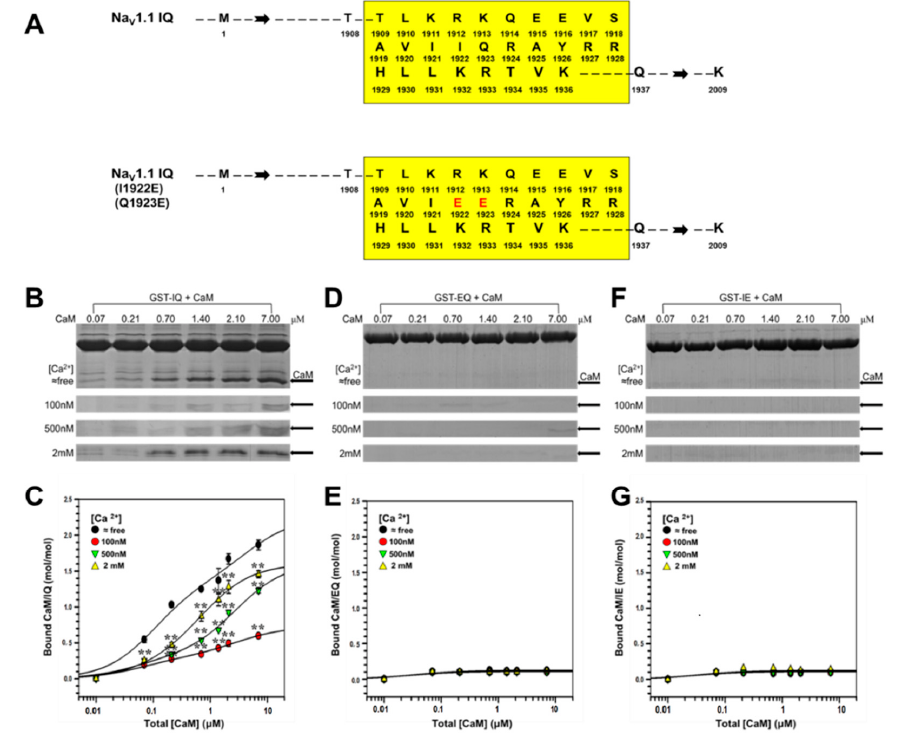
Figure 2. Interaction of the IQ of Na V 1.1 and its mutant with CaM by pull-down assay. ( A ) Schematic illustrations of Na V 1.1 IQ domain and its mutants EQ and IE. Amino acid sequences from human Na V 1.1 IQ are presented with black letter code. The mutated amino acid of Na V 1.1 EQ and IE is indicated with red letter. IQ, EQ and IE peptide contains amino acids from 1909 to 1936. ( B , D , F ) GST pull-down assay for the binding of CaM to IQ, EQ, or IE. ( B , D , F ) GST-fusion IQ, EQ, and IE was incubated with increasing concentrations of CaM (0.07 to 7 μ m) at fixed [Ca 2+ ] of ≈ free, 100 nM, 500 nM, and 2 mM. Protein bands are stained by Coomassie Brilliant Blue. CaM protein bands are pointed out by arrows ( B , D , F ). Bound CaM ( C , E , G ) are plotted against total [CaM] on a molar ratio basis (CaM/IQ, EQ or IE) with mean ± S.E. ( n = 4 for CaM). ** p < 0.01, compared with corresponding bindings at Ca 2+ -free conditions.